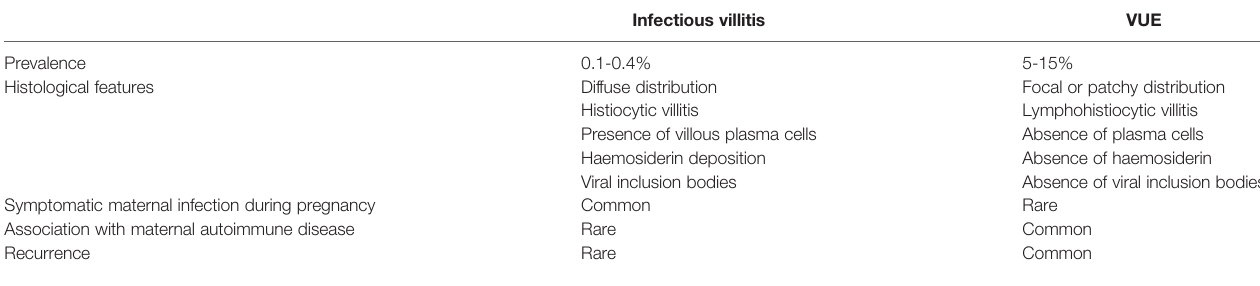
TABLE 3 | Comparison of clinical and histological features in infectious villitis and villitis of unknown etiology (VUE) (9).